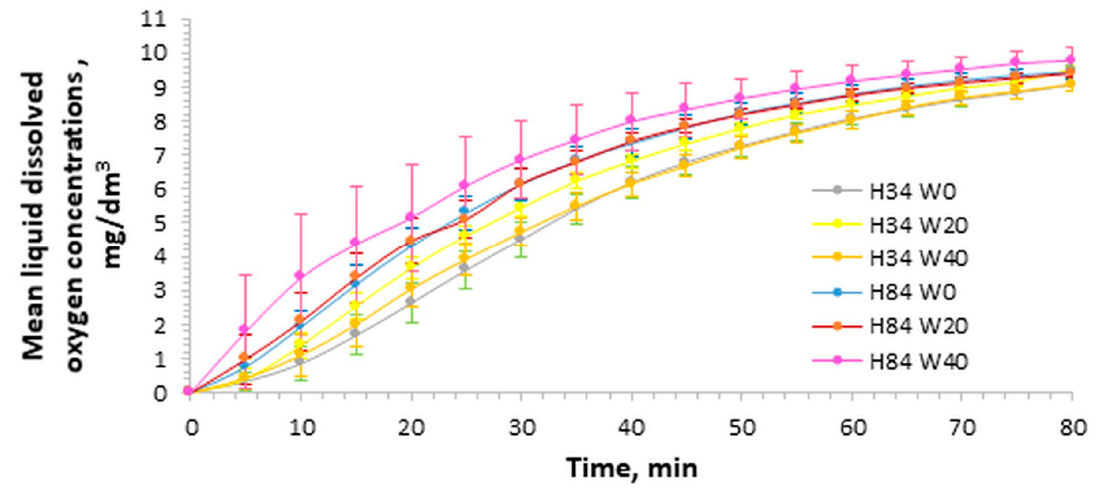
Figure 8. Mean circulation velocity v crs of liquid in the reactor .